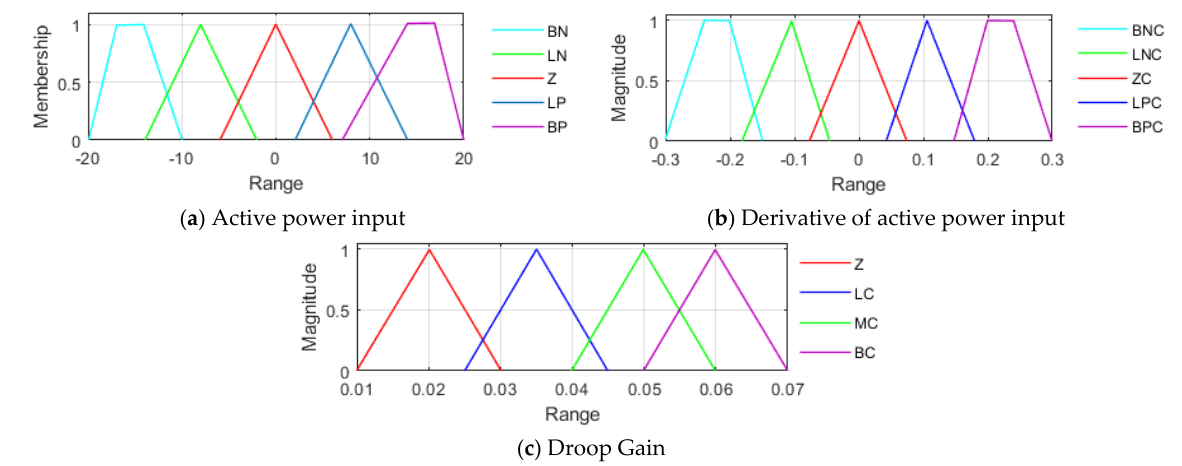
Figure 10. Fuzzy sets for active power input, its derivative, and for droop gain.